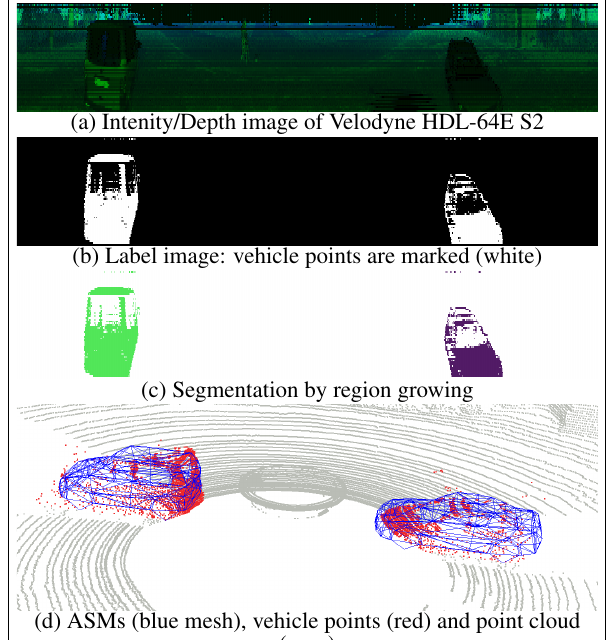
Figure 1. Data processing: from intensity/depth image via label image to